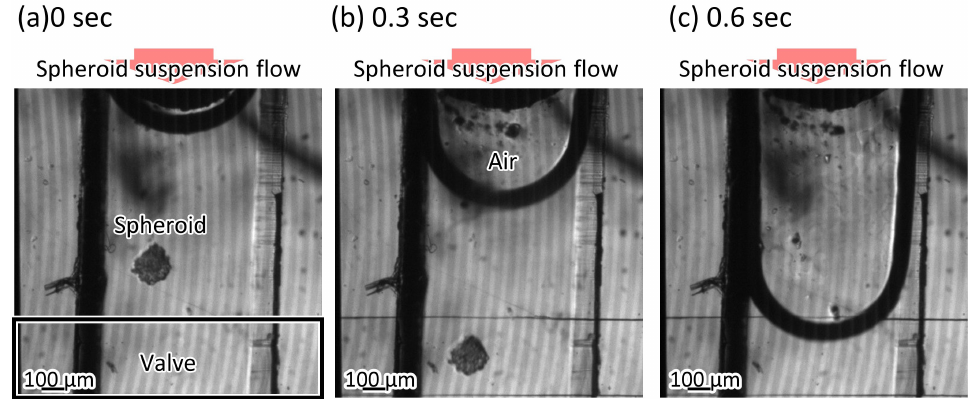
Figure 9. The spheroids passing through the